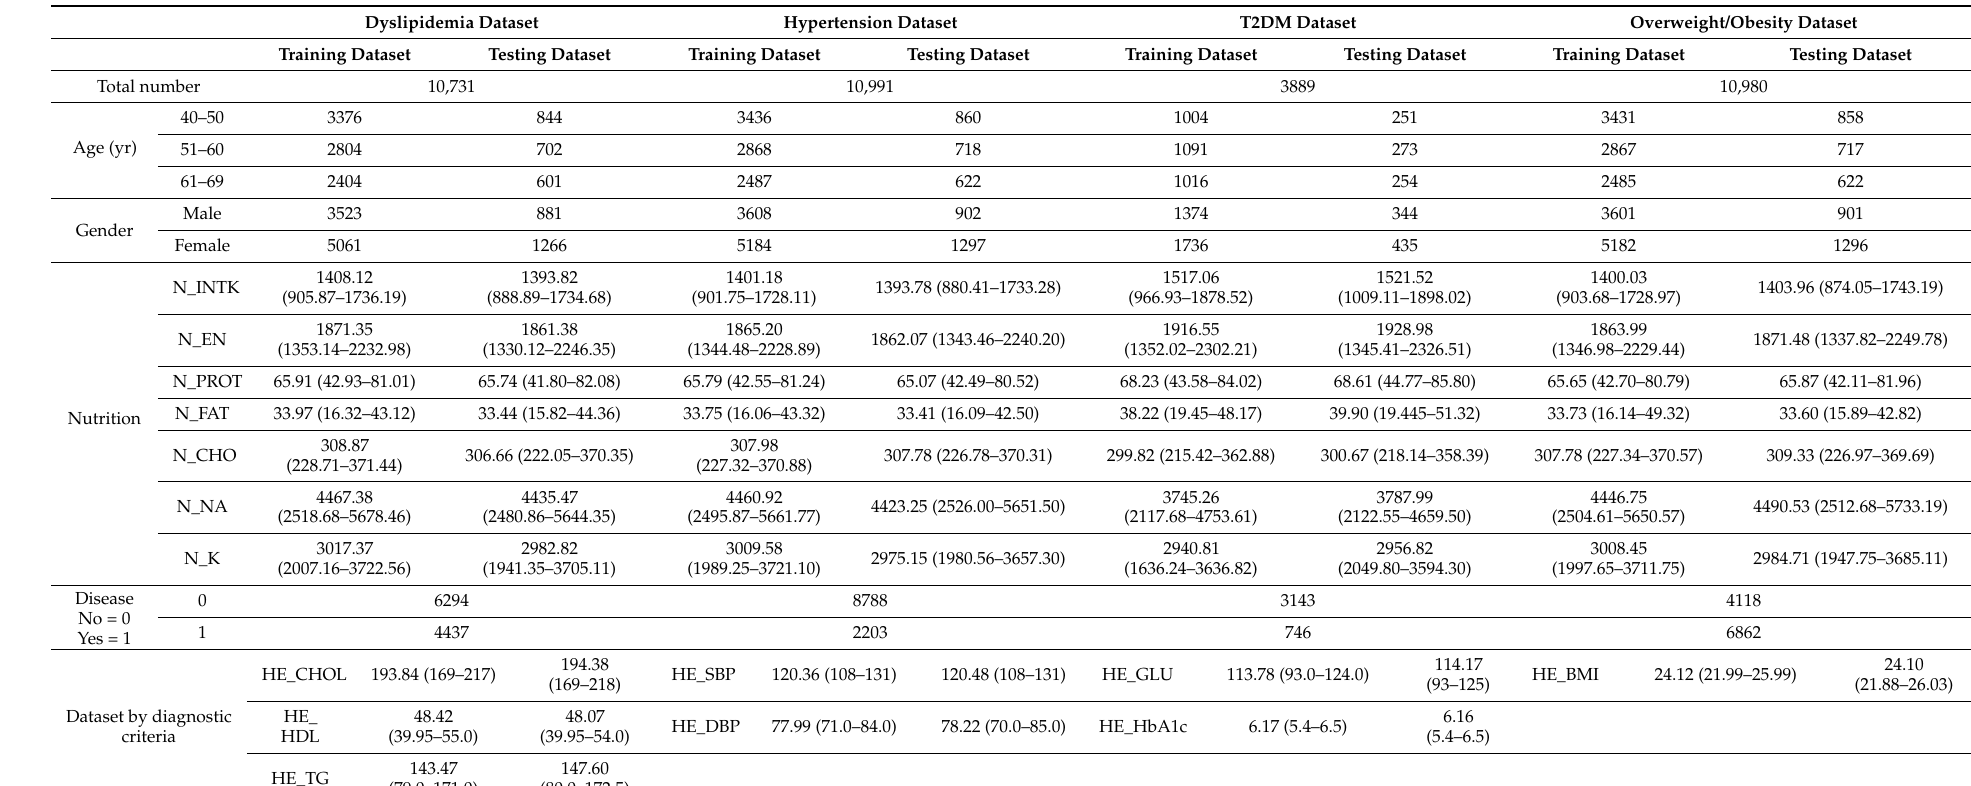
Table 4. Baseline characteristics of